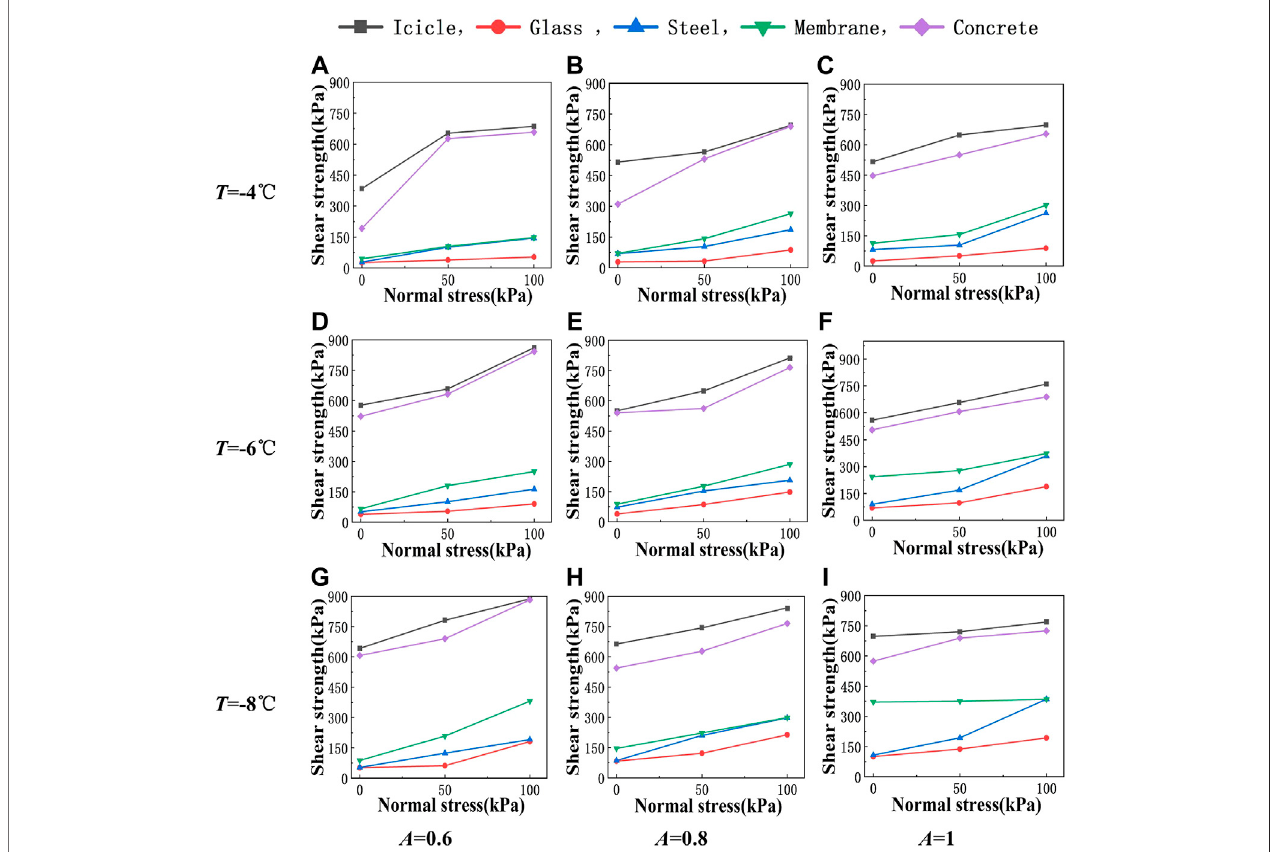
FIGURE8| Variationoftheshearstrengthwithnormalstress:row1 (A – C) T = − 4 ° C,row2 (D – F) T = − 6 ° C,row3 (G – I) T = − 8 ° C,column1 (A,D,G) A =0.6,column 2 (B,E,H) A = 0.8, and column 3 (C,F,I) A = 1.